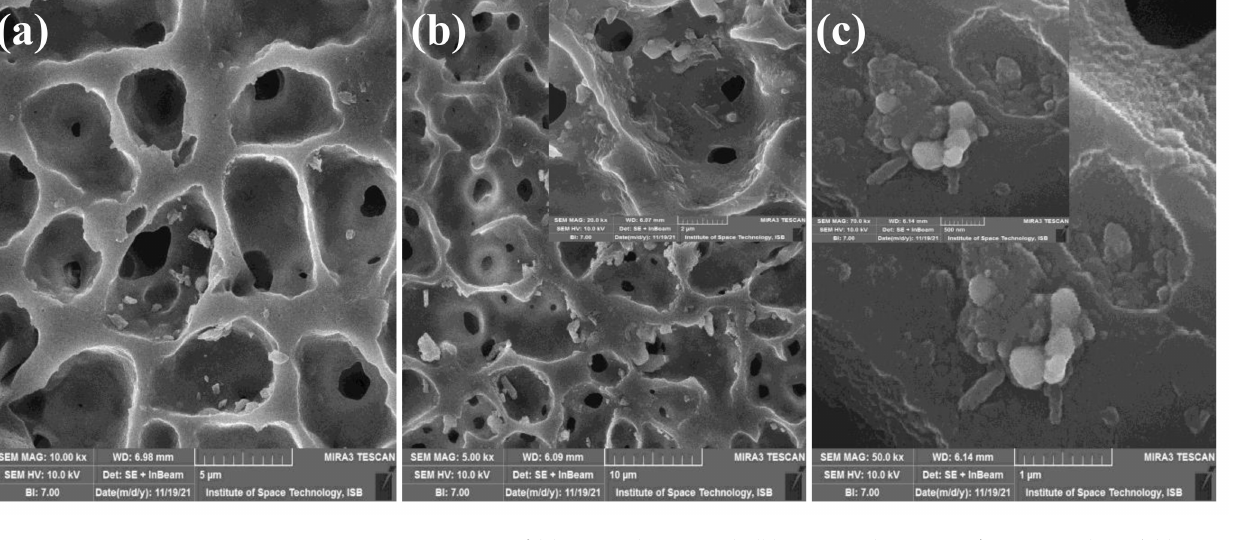
Figure 3. SEM imaging of ( a ) TN-02 (TPU-NiO), ( b ) TNG-02 (TPU-NiO/NH 2 -GO-1), and ( c ) TNG-10 (TPU-NiO/NH 2